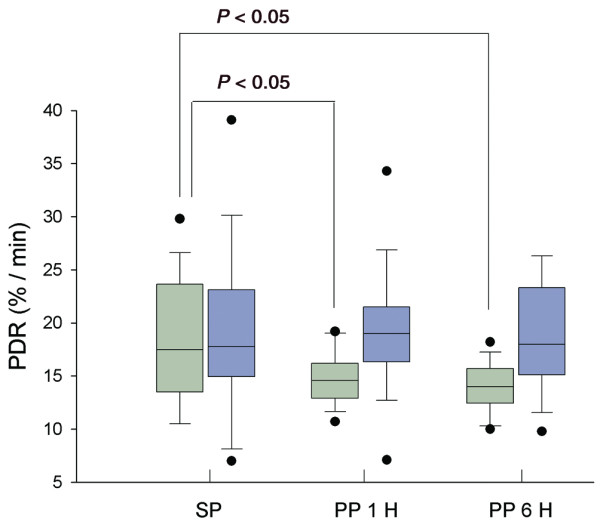
Effects of both supports on the plasma disappearance rate (PDR) of indocyanine green. The different durations of study are reported along the x-axis: SP, PP 1 H and PP 6 H represent baseline in supine position, prone position at 1 hour and prone position at 6 hours, respectively. Pale gray box, foam mattress; dark gray box, air-cushion mattress. Each box plot represents the median, the 25th and 75th centiles, and the largest and smallest values that are not outliers. Outliers are represented as filled circles. P < 0.05 by Tukey's post-hoc test